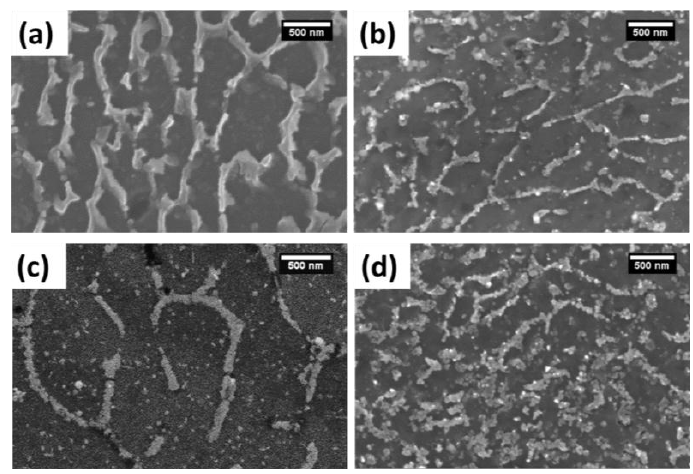
Figure 2. FESEM micrographs of A357 samples’ cross-section built at ( a ) 100; ( b ) 140; ( c ) 170; and ( d ) 190 °C.